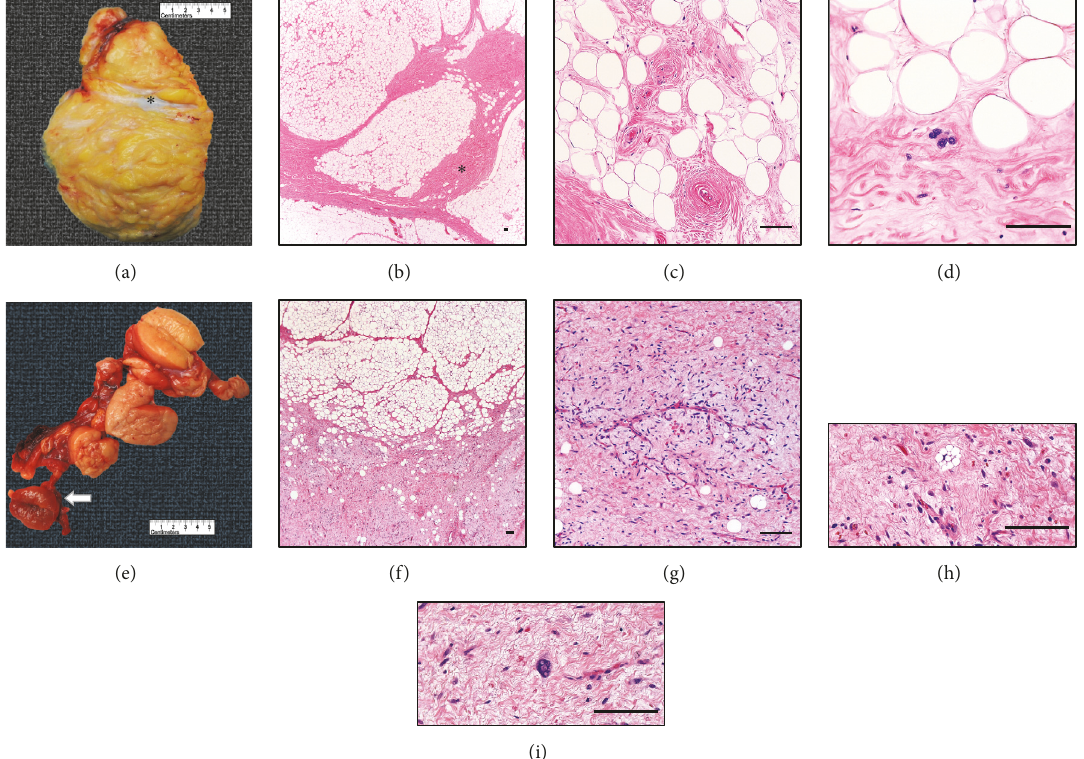
Figure 2: Gross and microscopic tumor examination in case 1 (a-d) and case 2 (e-i). See text for further explanation. Bar= 100 𝜇